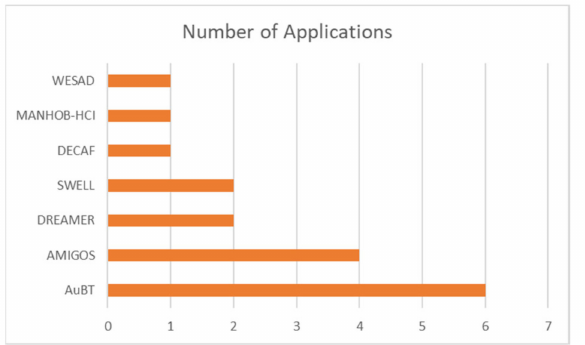
Figure 8. The number of times datasets were applied in different research studies found in the summarized literature.